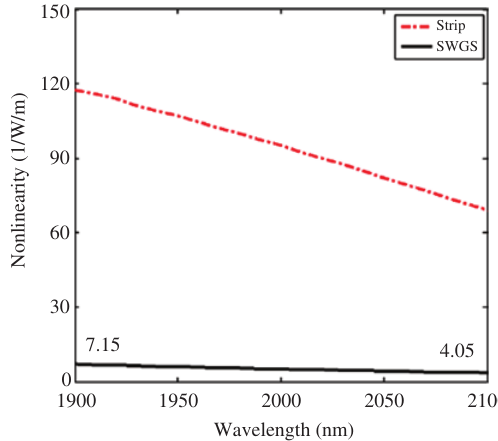
Figure 6: Calculated effective nonlinear coefficients of strip wave- guide and SWGS waveguide vs. wavelength (silicon width: 375 nm, slot width: 100 nm, period: 300 nm, duty cycle: